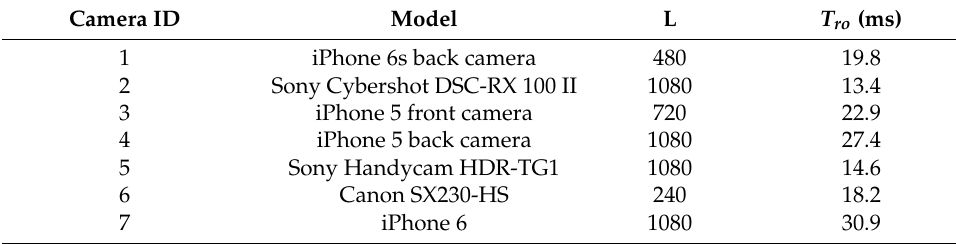
Table 1. Cameras and parameters used in our